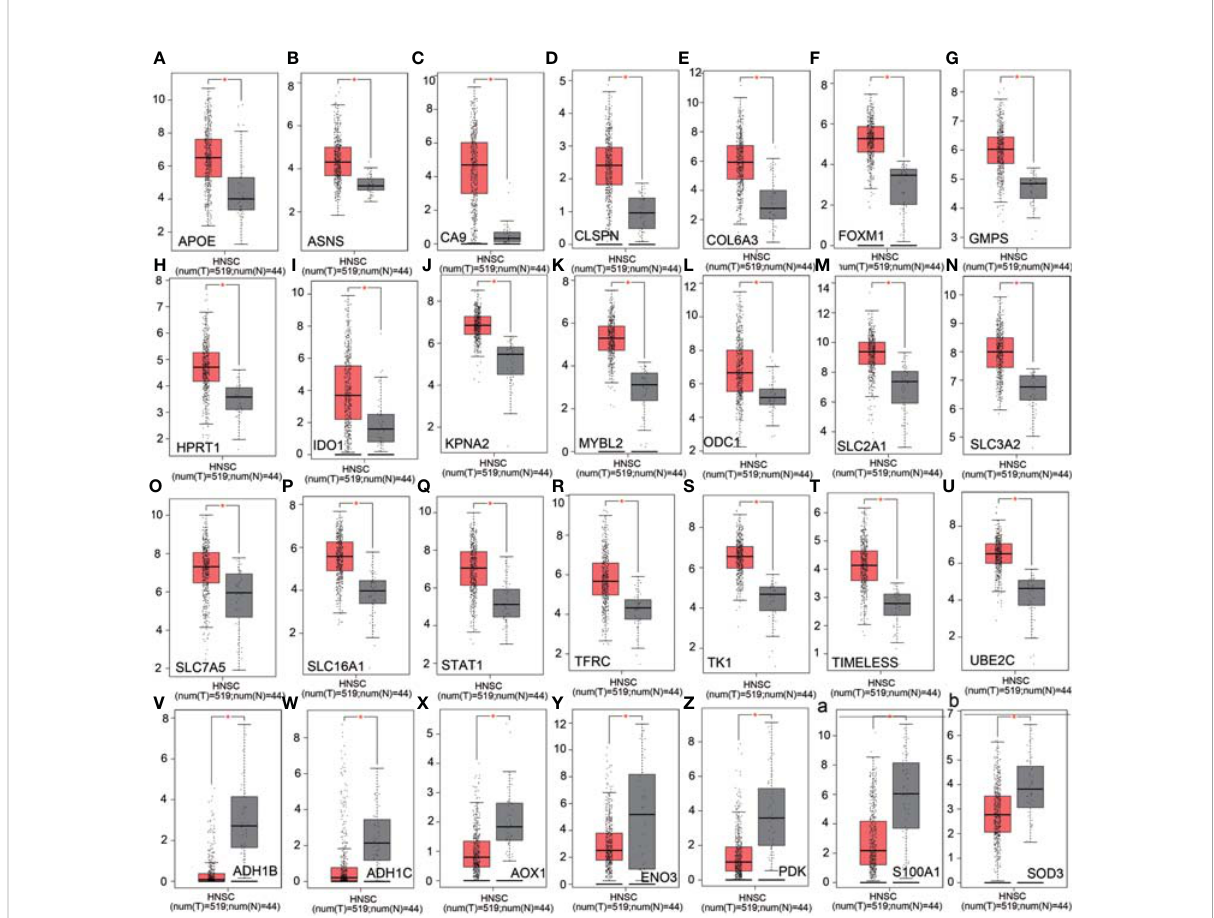
FIGURE 6 Analysis of relative expression level of altered genes in nCounter ® Metabolic Pathways Panel in TCGA HNSCC database. (A – U) Relative expression levels of upregulated genes in Metabolic Pathways Panel in TCGA HNSCC database. (V – Z) and (a, b) Relative expression levels of downregulated genes in Metabolic Pathways Panel in TCGA HNSCC database. Red: HNSCC tissues. Gray: adjacent normal tissues. Ordinate: log 2